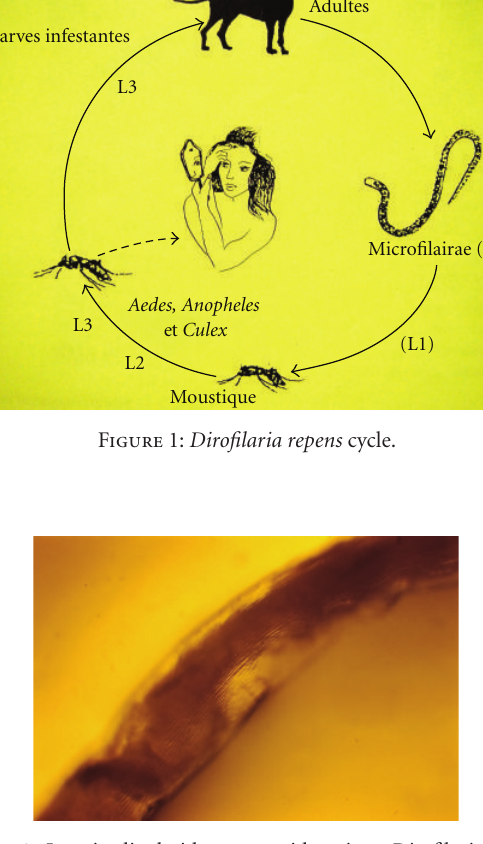
Figure 2: Longitudinal ridges are evident in a Dirofilaria repens adult nematode.